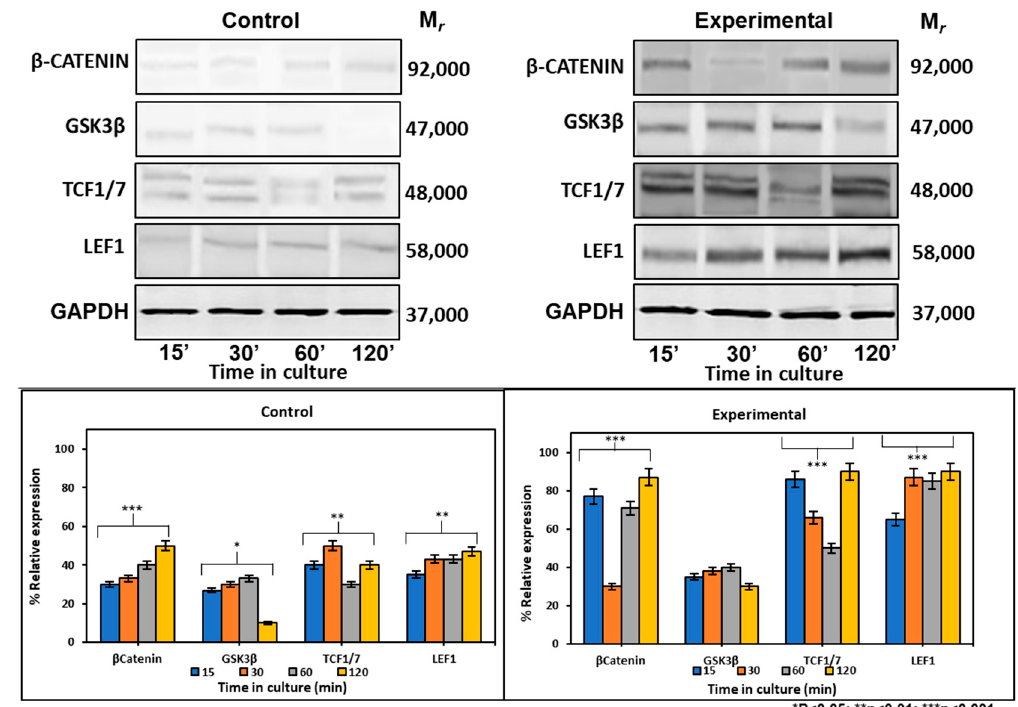
Figure 5. Expression of cell signaling pathway Wnt/ β -catenin-related markers at the protein level. Control cultures showed that β -catenin, GSK, TCF1/7 and LEF1 showed low expression at 15, 30, 60 and 120 min of culture. HOMSCs cultures treated with CEMP1-p4 at 4 µg/mL increased β -catenin, TCF1/7 and LEF1 expression at 15, 30, 60 and 120 min respectively.